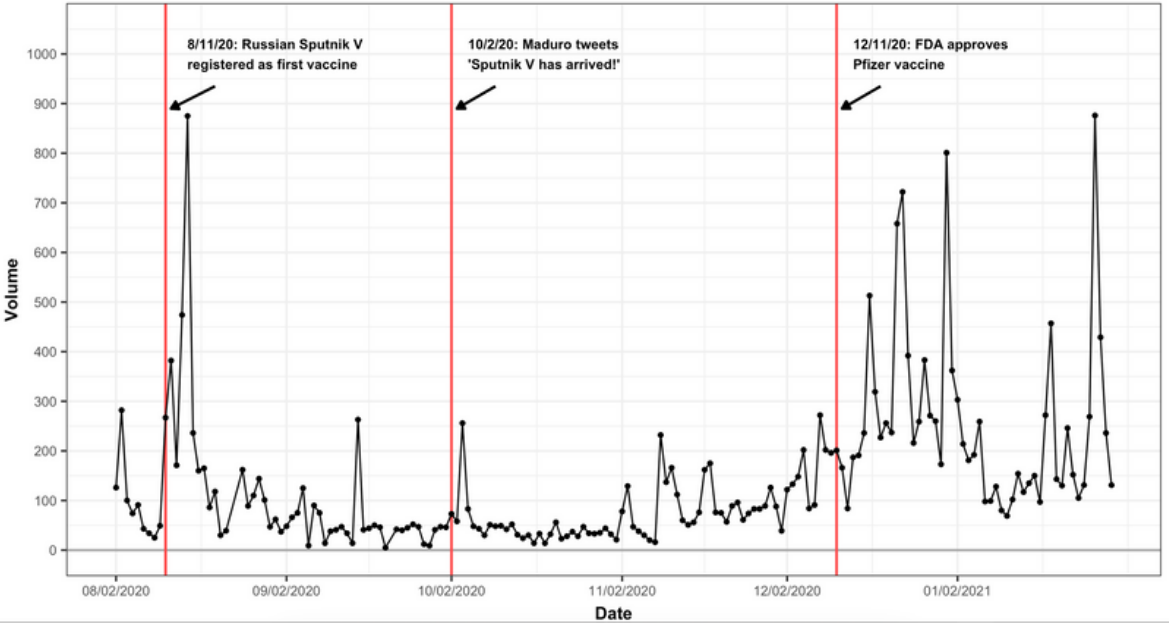
Figure 1. Time-series plot for vaccine myths. From COVID Decahose of Spanish